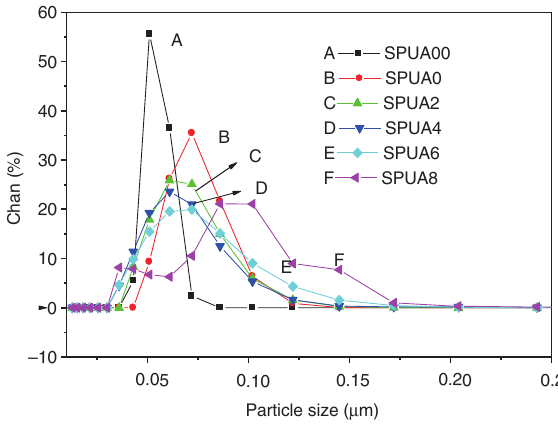
Figure 3: Particle size and size distribution of SPUA emulsions.